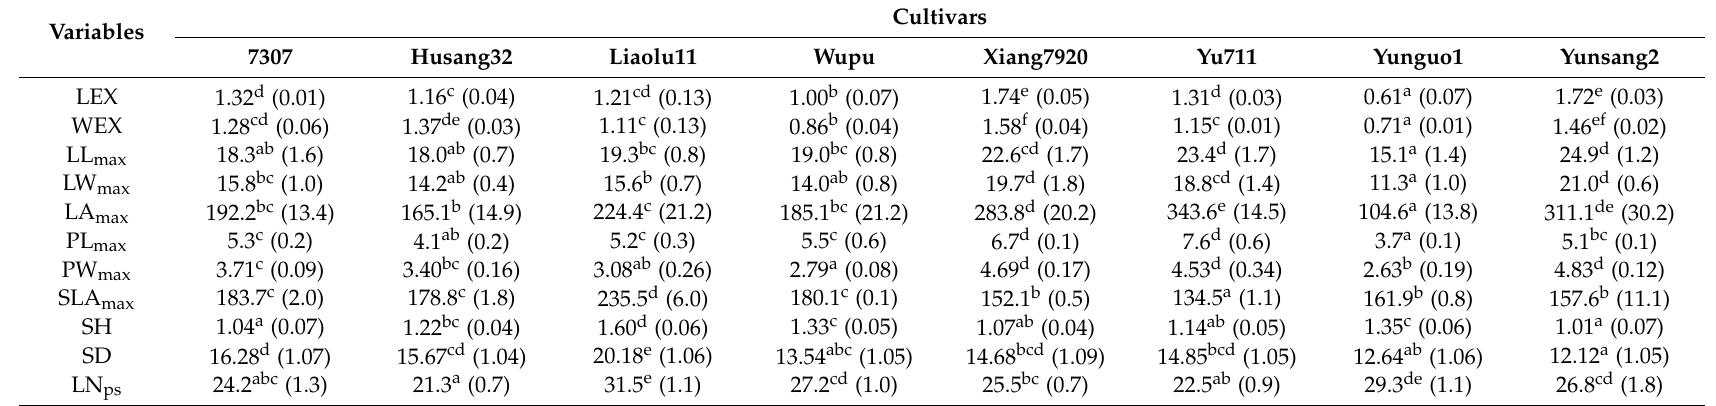
Table 1. Growth-related morphological properties of 3-year-old mulberry trees from eight cultivars. For each variable, the presented data are means (SE). Di ff erent letters after the mean values in the same row indicate significant di ff erence at p < 0.05. LEX: leaf length expansion rate (cm day − 1 ), LEX: leaf width expansion